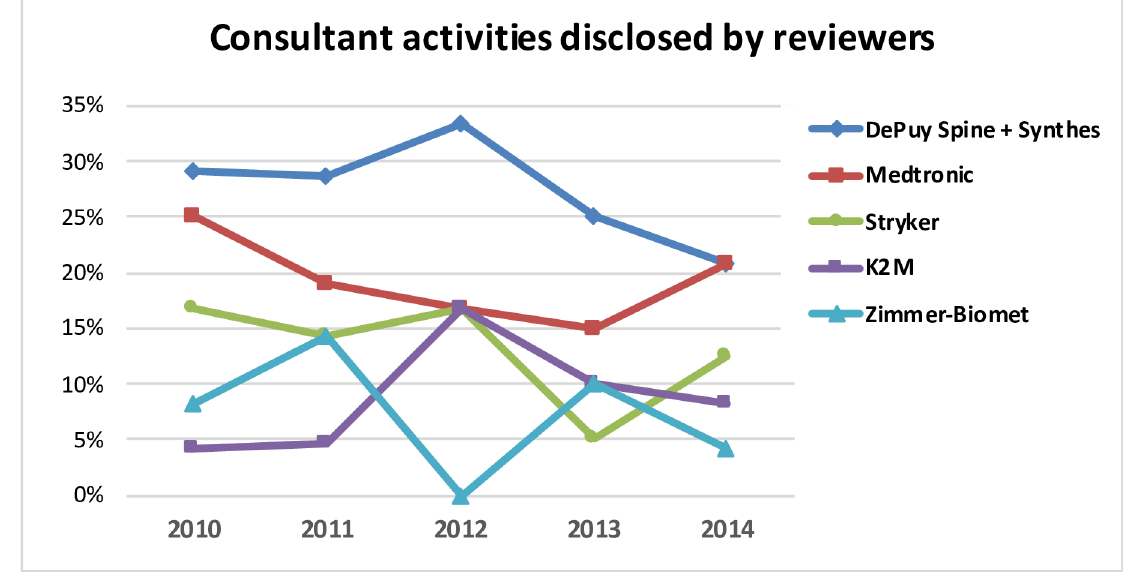
Fig 7. Distribution of consultant activities disclosed by the reviewers in relation to the total number of type b major COIs.